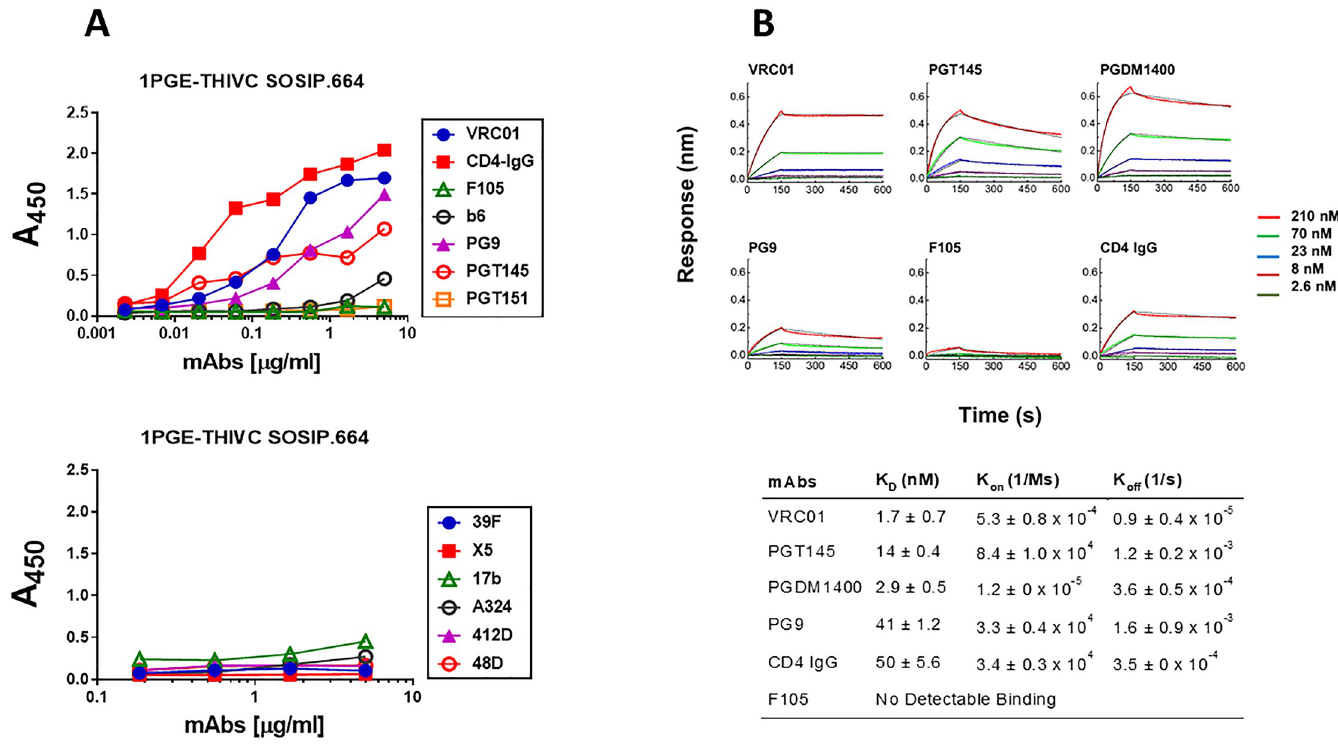
Fig 2. Antigenic properties of 1PGE-THIVC. A . Binding of 1PGE-THIVC with neutralizing and non-neutralizing mAbs by ELISA. B. Binding kinetics of 1PGE-THIVC to neutralizing and non-neutralizing mAbs by biolayer interferometry (BLI) kinetic analysis.